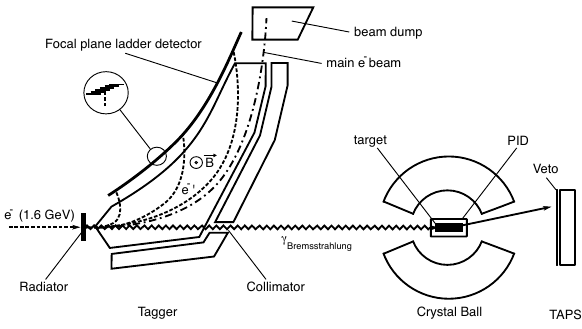
Figure 2. Schematic view of the setup at the tagged-photon beam experiment A2 at